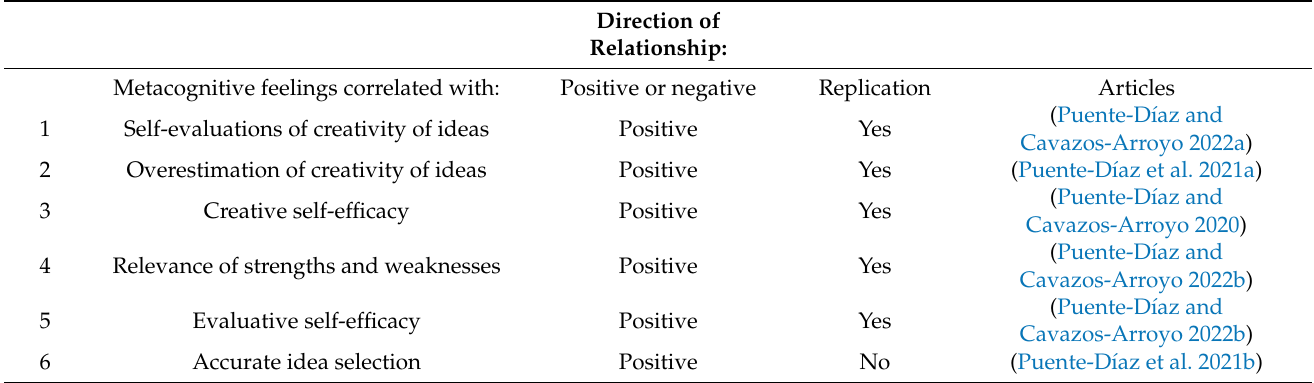
Table 1. Summary of